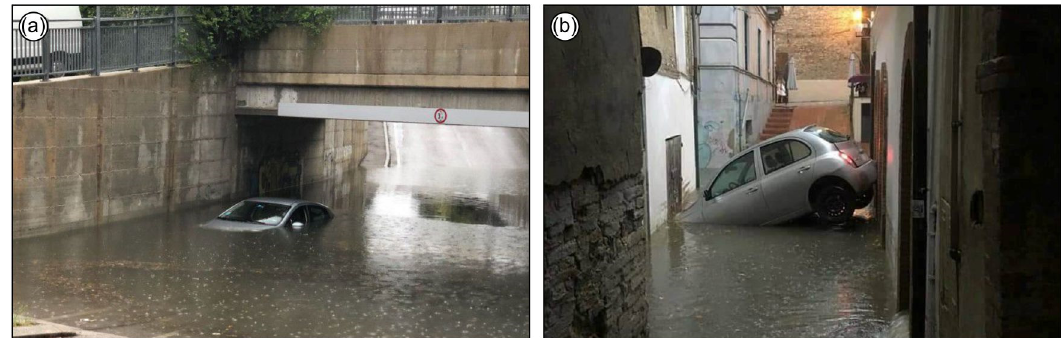
Figure 9. Cars were stranded after the June 2018 flash flood in the urban area of Lanciano: ( a ) near the industrial area of Lanciano, in the southern area of the municipality; ( b ) in the historic center of Lanciano.